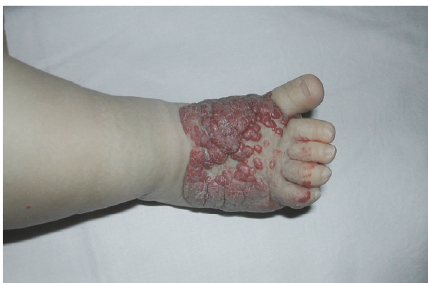
Figure 4: Case 4. Pebbled patches of bright-red hemangioma and the distal part extending onto the digits presenting reticulated network-like telangiectasia morphology.